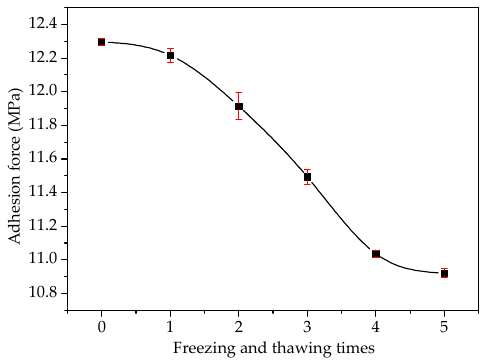
Figure 6. Effect of freeze–thaw cycles on the adhesion at the asphalt–steel slag interface.